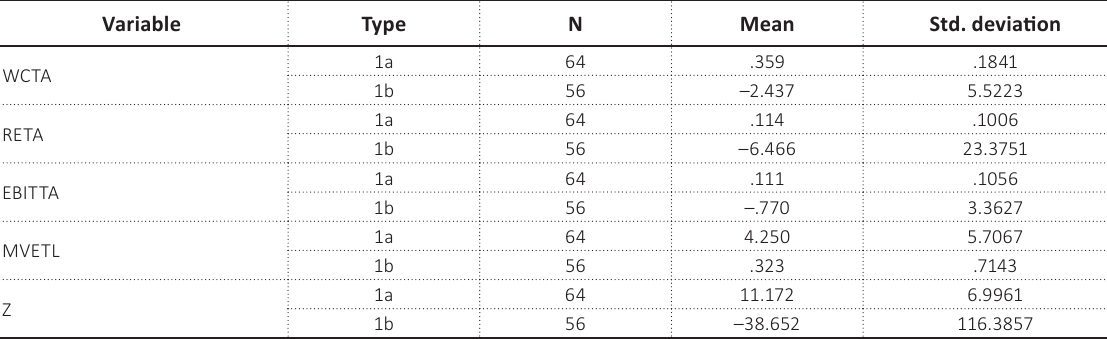
Table 3. Descriptive statistics of Group 1a and Group